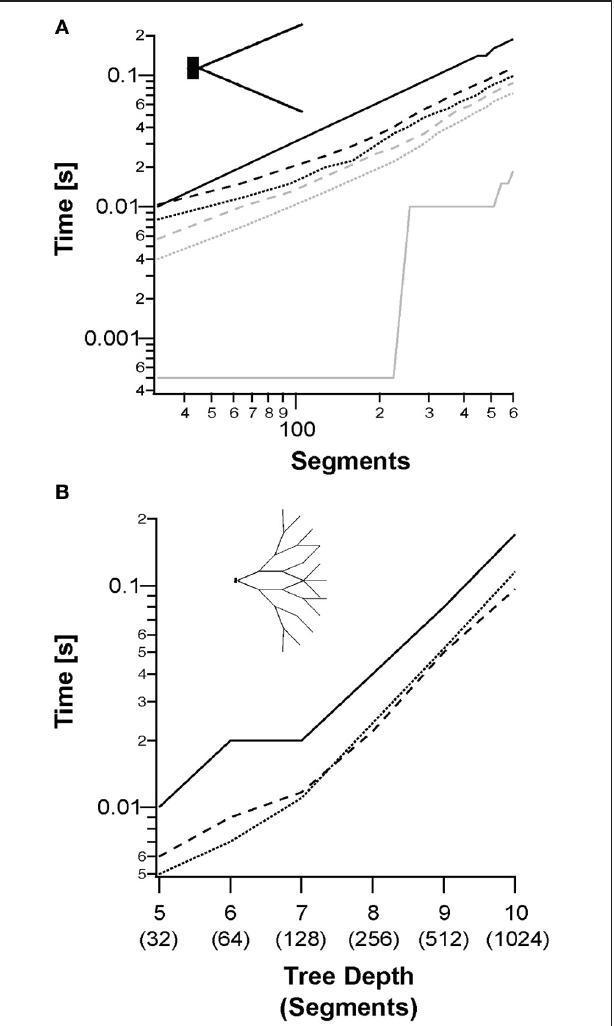
FIGURE 4 | Simulation of a single sweep of a single neuron of different topologies, models, and scale. (A) Median runtimes of a fork morphology (inset) with increasing number of segments for: NEURON simulation (solid lines); segment-based parallelization (dotted line); and branching-based parallelization (dashed line). The Hodgkin–Huxley model is shown in black and the passive model in gray. (B) Median runtimes of full binary tree morphologies (inset) using the Hodgkin–Huxley model with increasing tree depth. The passive model is not shown for clarity.